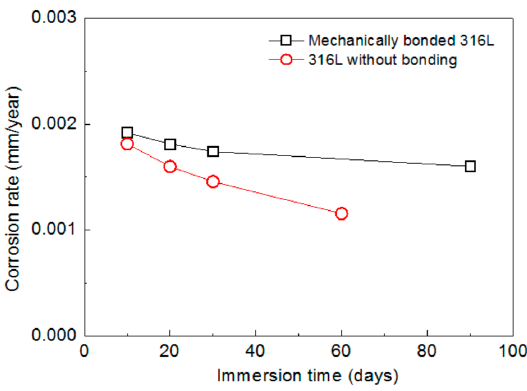
Figure 4. Variations in corrosion rates of 316L according to periods of immersion under atmospheric conditions.